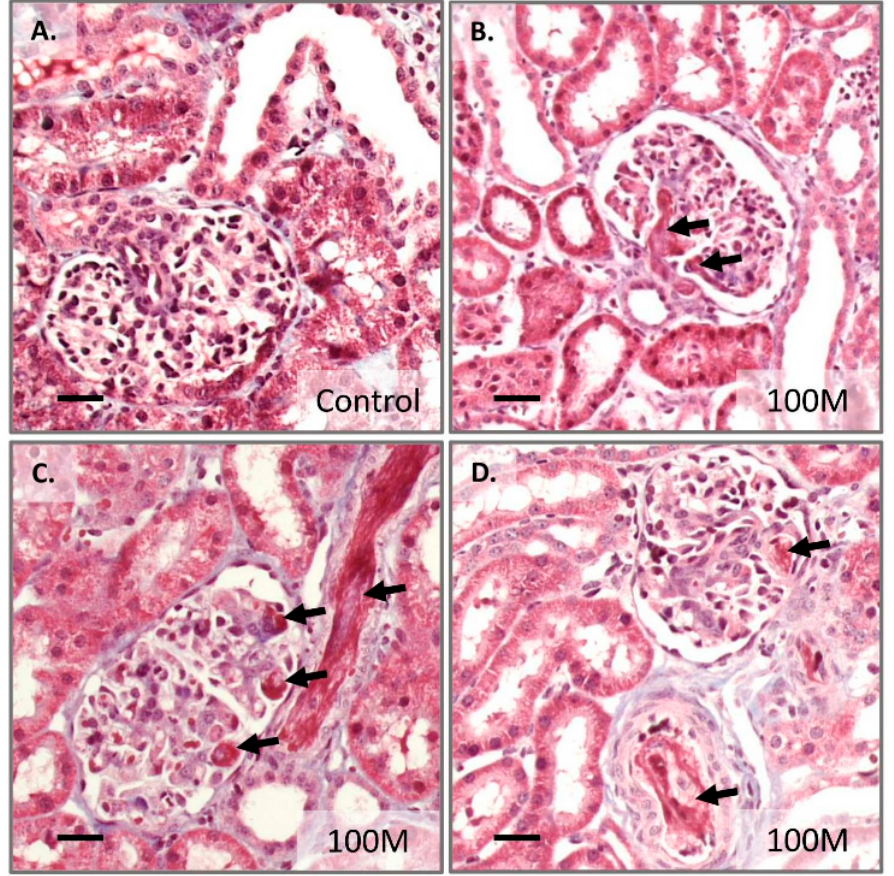
Figure 7. Masson’s trichrome stained kidney tissue sections demonstrating microthrombi (black arrows). Kidney material was collected about two hours after intra-renal arterial administration of hundred million MSCs (right kidney). ( A ) An example of a healthy control kidney ( B – D ) representa- tive pictures of the treated kidneys. Bar = 50 μ m.